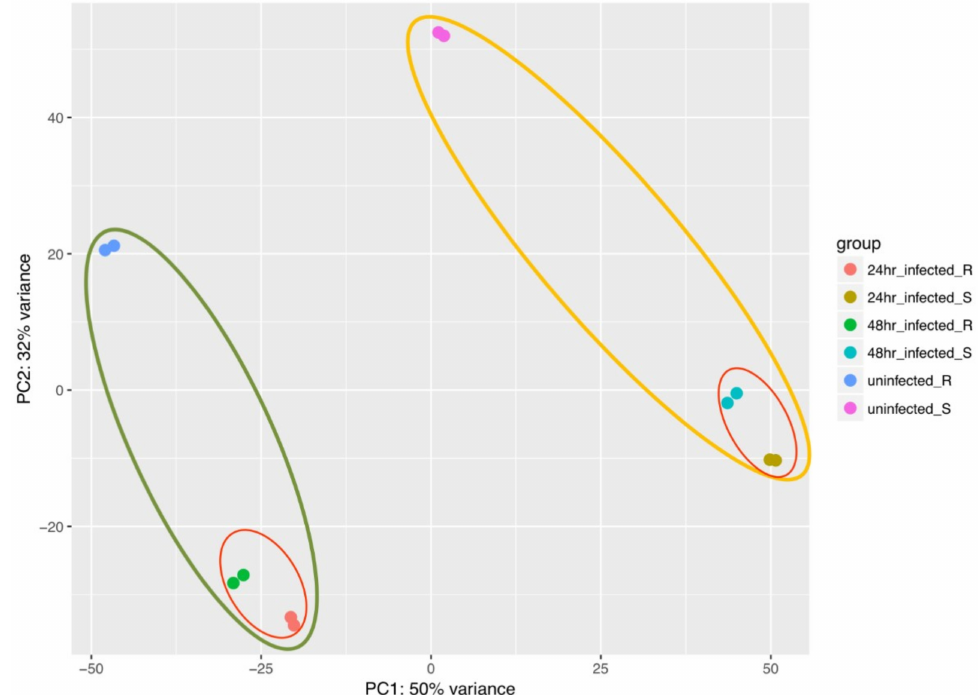
Figure 3. Principle component analysis (PCA) plot. Sp-R and Sp-S genotype factor showed variation among all their treated mock samples. Green oval is encompassing all Sp-R samples and red oval within the green oval is showing infected Sp-R samples at each time point. Yellow oval has enclosed all Sp-S samples within that red is encircling the infected ones. Color key presenting the sample groups is given at the left. Each colored dot represents a single sample. Replications are indicated by same color